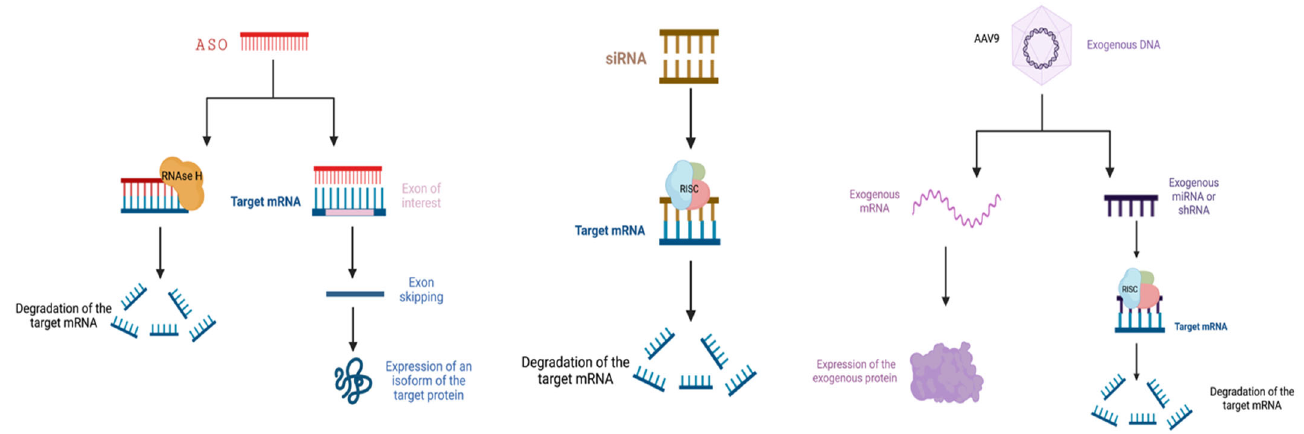
Figure 1. Different strategies used in gene therapy.